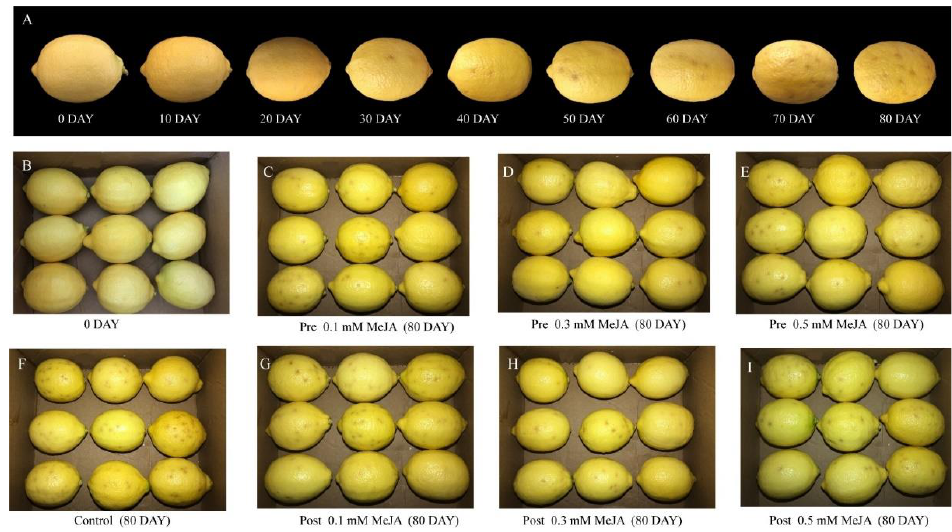
Figure 1. External appearance of ‘Eureka’ lemon during storage at 7–10 ◦ C. ( A ) External appearance changes of control fruits after 0, 10, 20, 30, 40, 50, 60, 70 and 80 days of cold storage; ( B ) External appearance of all treated fruits in cold storage for 0 day; ( C – E ) External appearance of fruits treated with pre-harvest 0.1, 0.3, and 0.5 mM MeJA after 80 days of cold storage, respectively; ( F ) External appearance of control fruits after 80 days of cold storage; ( G – I ) External appearance of fruits treated with post-harvest 0.1, 0.3, and 0.5 mM MeJA after 80 days of cold storage, respectively.